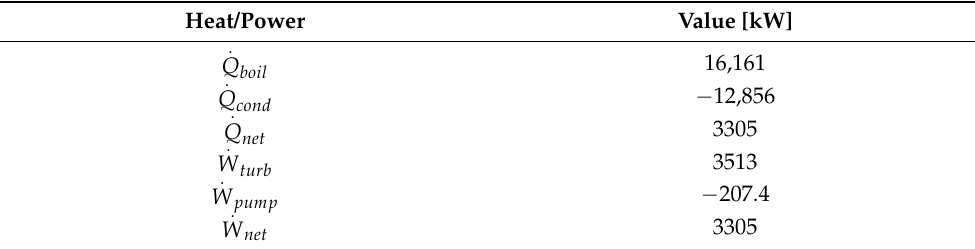
Table 2. Heat and Power invested and produced in the Organic Rankine Cycle.